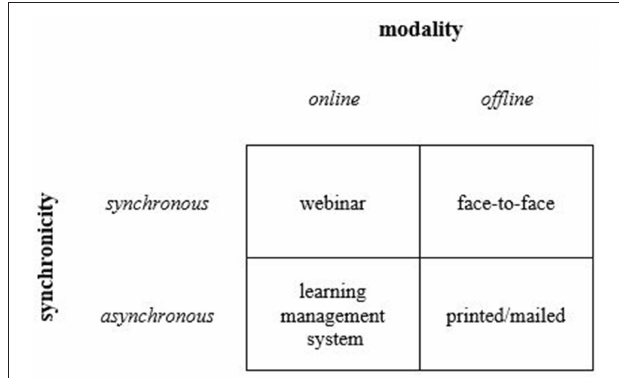
FIGURE 1 | Learning